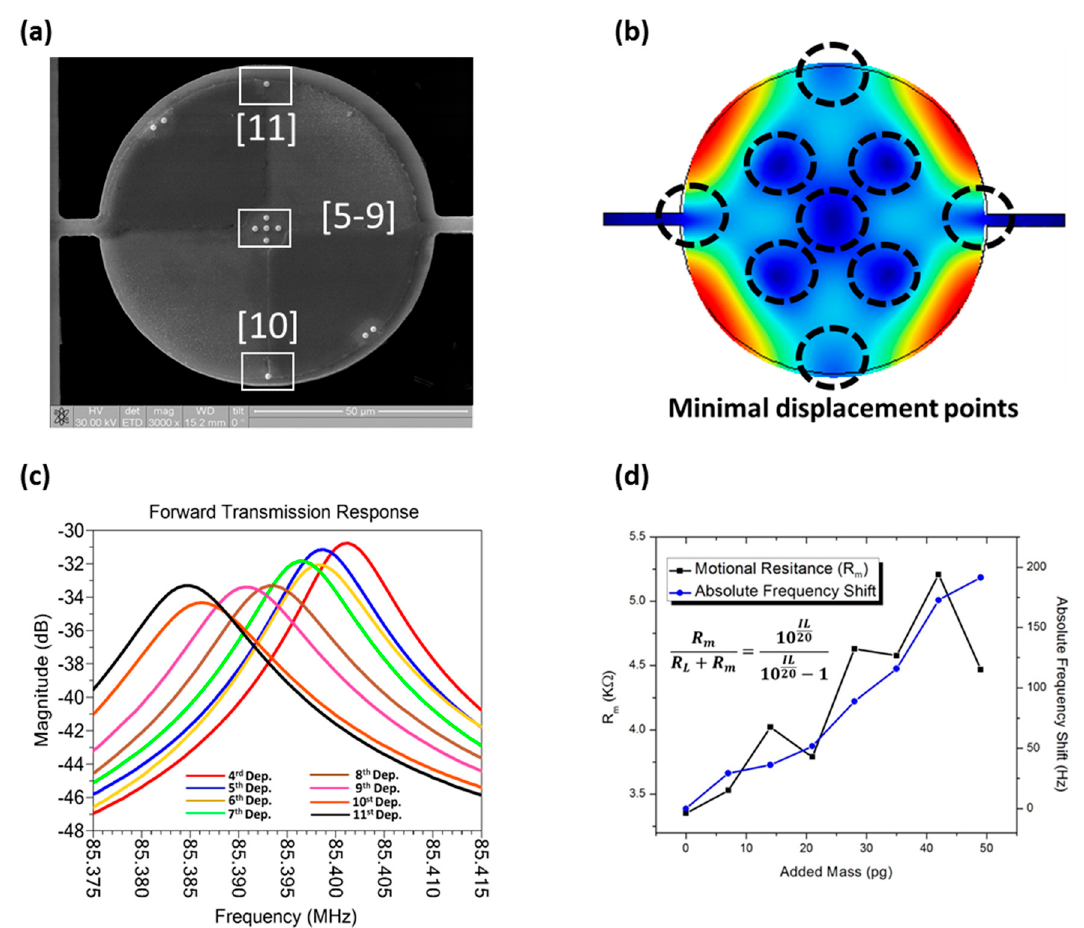
Figure 9. ( a ) SEM image of showing the location of sequentially deposited Pt/Ga micro-pellets adjacent to the minimum displacement points; ( b ) COMSOL® modal simulation illustrating the minimum displacement areas of the corresponding fourth-order contour mode; ( c ) measured frequency responses showing the frequency drift induced by the added extra mass of each micro-pellet; ( d ) measured absolute frequency shift and motional resistance ( R m ) of the device versus loaded mass showing the impacts of the micro-pellets on the insertion loss and energy dissipation